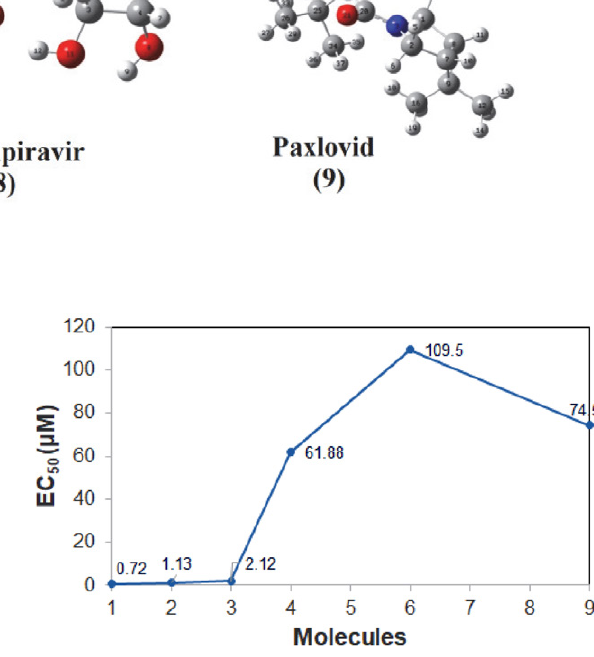
Figure 3. In vitro half-maximal effective concentration (EC 50 ) of